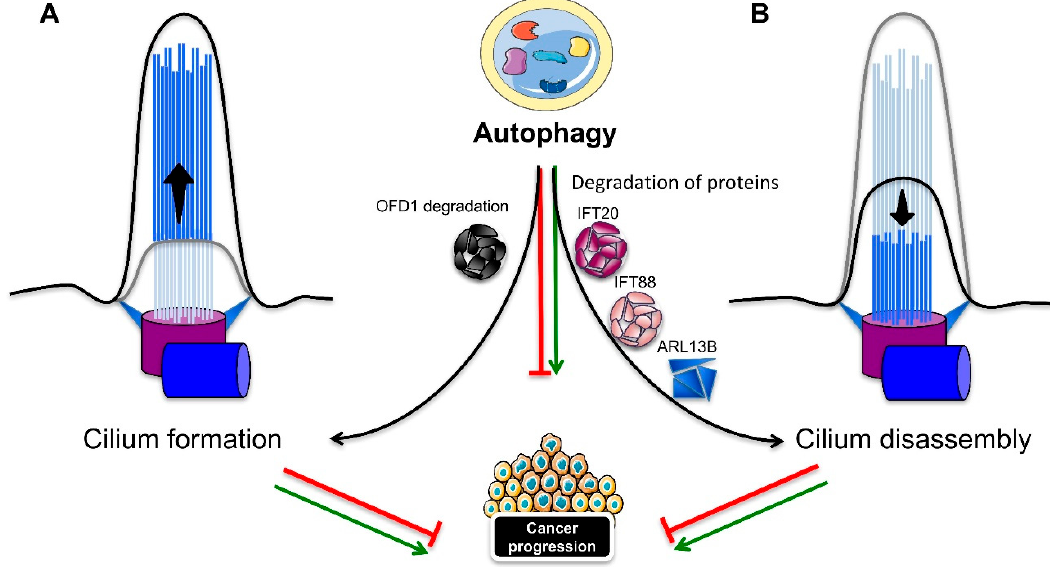
Figure 4. Cilia-autophagy axis. Autophagy has an opposite effect on ciliogenesis: ( A ) Induction of cilia formation, by suppressing negative regulators of ciliogenesis, such as the centriolar satellite OFD1 protein, or ( B ) induction of cilia disassembly, by degrading proteins that are essential for ciliogenesis, such as IFT20, IFT88, and ARL13B. New molecular effectors mediating the cilia-autophagy axis are emerging. Autophagy can both repress and induce cell transformation, but whether and how autophagy influences tumorigenesis through cilia, or vice versa, requires further analysis. ARL13B: ADP ribosylation factor like GTPase 13B; IFT: intraflagellar transport; OFD1: oral-facial-digital syndrome 1.